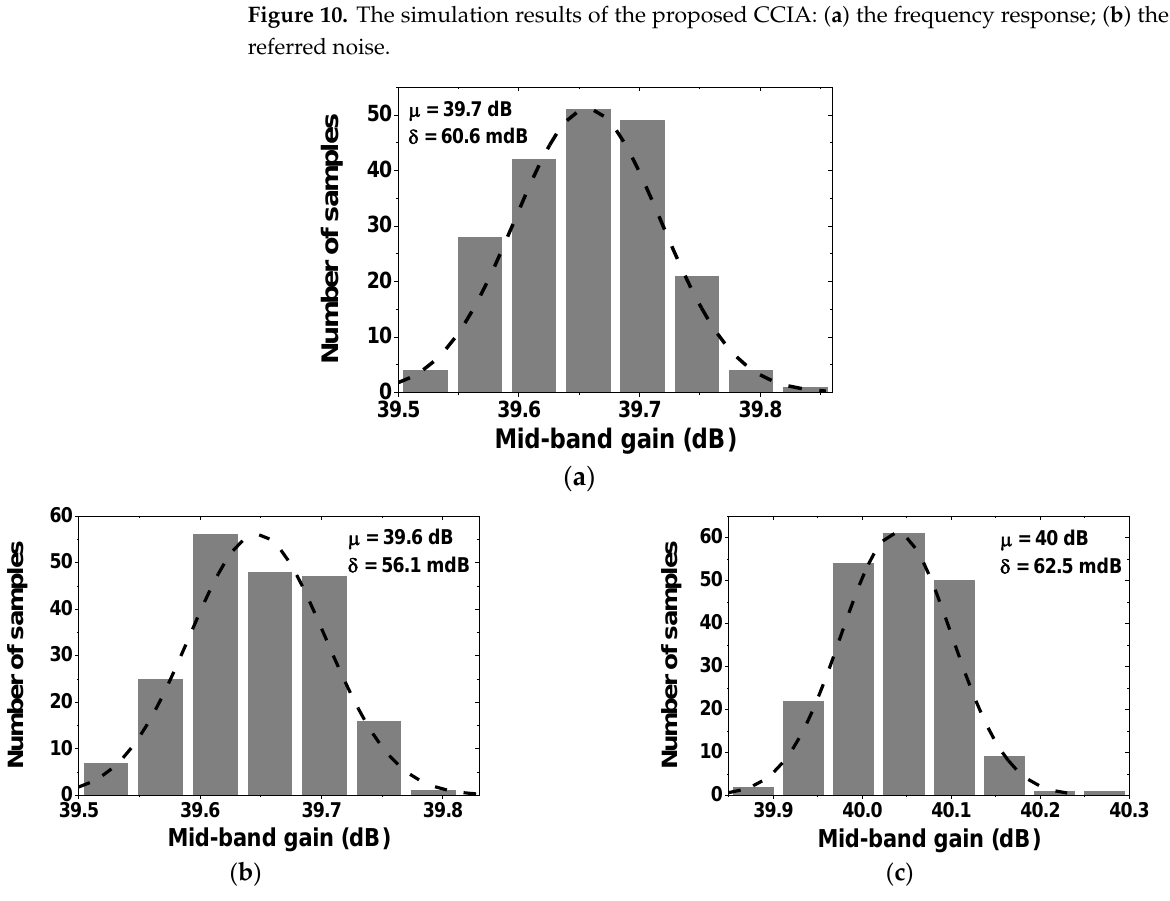
Figure 11. Monte Carlo simulation results of the mid-band gain of the proposed CCIA for different values of V DD : ( a ) V DD = 1 V, ( b ) V DD = 0.9 V, and ( c ) V DD = 1.1 V.